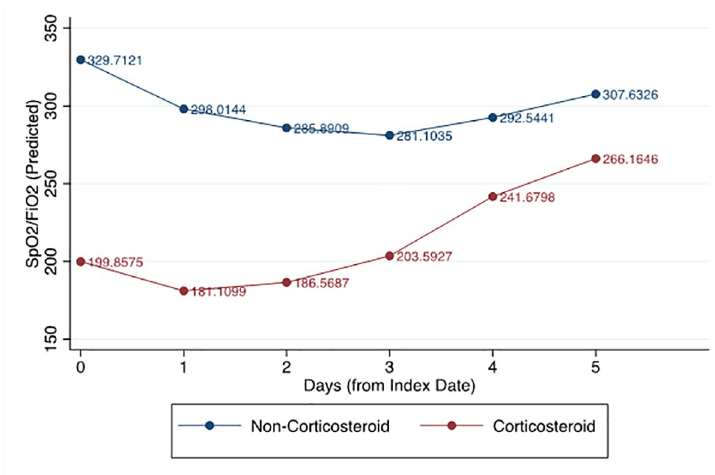
Fig 2. Comparison of trend of mean SpO 2 /FiO 2 ratio since index date with and without corticosteroid. (Tables 1 and 3) . Using multivariable linear regression, length of stay was lower in corticoste- roid cohort but statistically non-significant (coefficient -1.06; 95% CI, -4.26 to 2.14; P = 0.515).